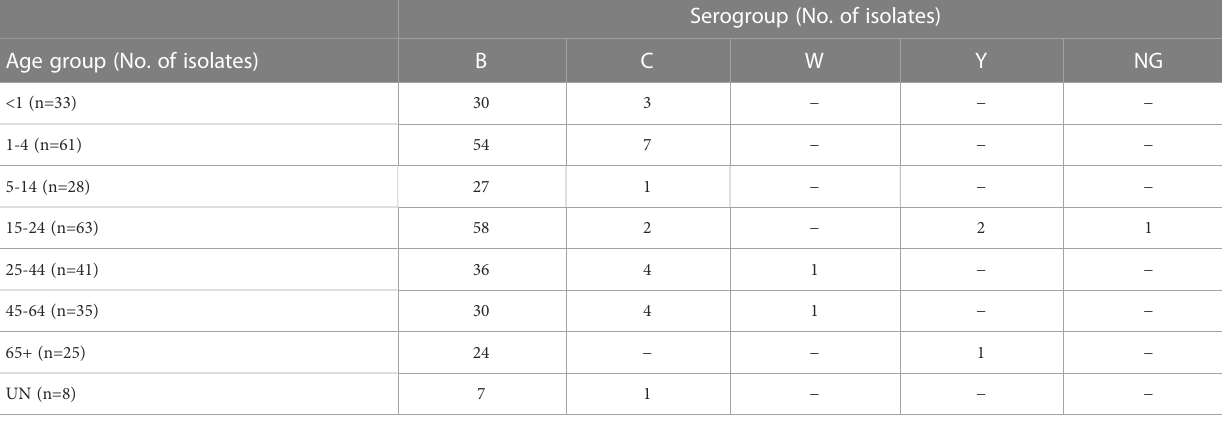
TABLE 3 Serogroup distribution of N. meningitidis isolates by age group. Age group (No. of isolates)